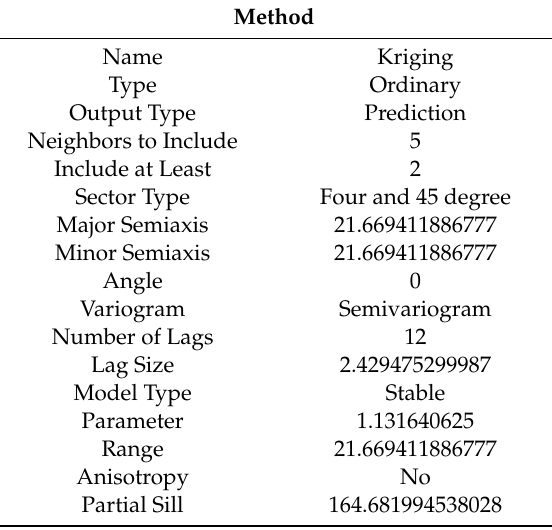
Table 1. The field study